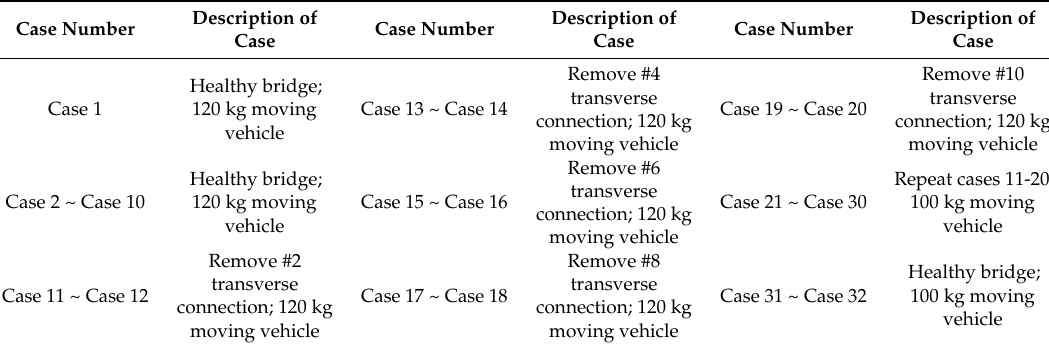
Figure 13. Photo of the devices designed to simulate the damage of the transverse connection between the two T-shaped beams. Table 4. Description of all cases for the quasi-static load tests on the model bridge.